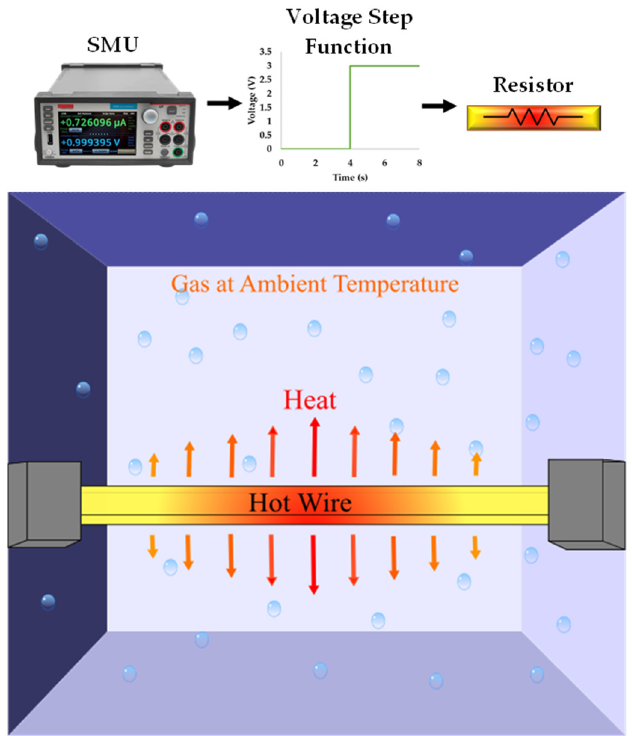
Figure 6. An illustration of the working principal behind the transient hot wire method. The resistor is biased with a voltage step to initiate the measurement.